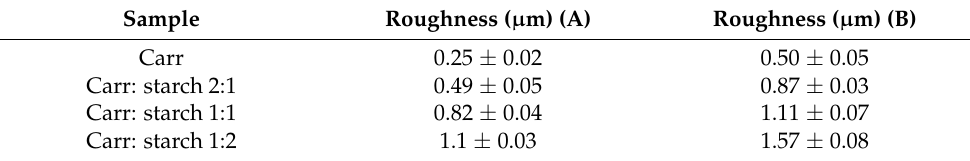
Table 1. Surface roughness values of Carr/starch membranes before (A) and after (B) enzymatic treatment. Sample